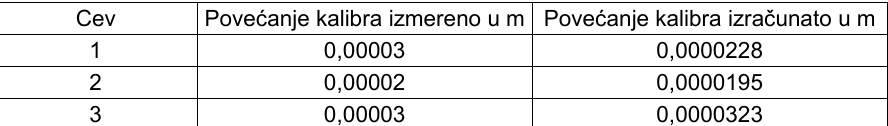
Measured and calculated caliber